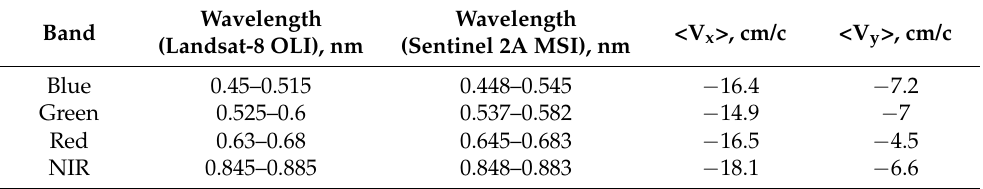
Table 1. Wavelengths of the studied bands and corresponding mean horizontal velocities.